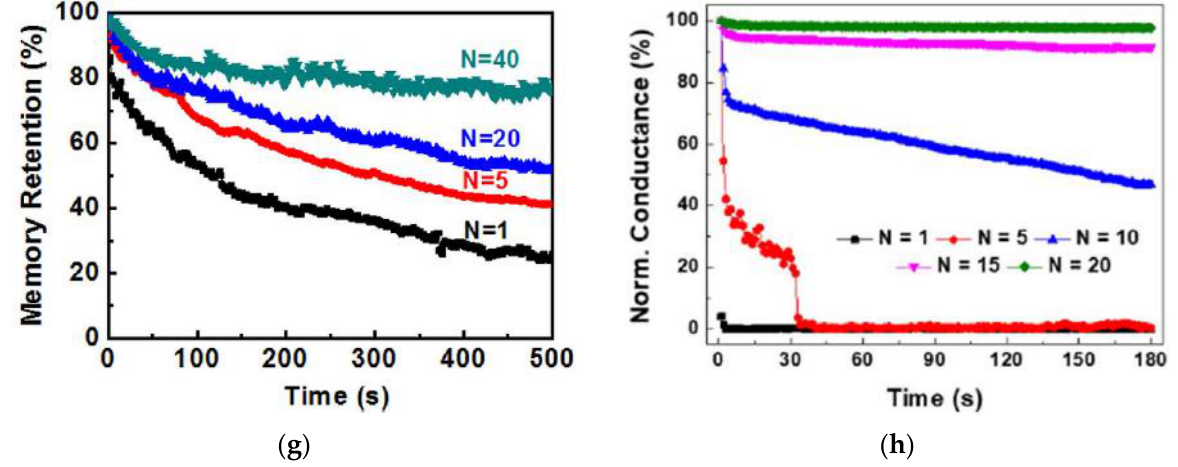
Figure 4. Current (memory) level and retention time affected by input pulse amplitude, which was demonstrated in ( a ) a chicken albumen transistor [43] and ( b ) a honey-memristor [17], pulse width, which was demonstrated by ( c ) a chicken albumen transistor [43], ( d ) a maltose-ascorbic acid electrolyte (MAE) gated transistor [56], and ( e ) a honey-memristor [17], and pulse number, which was demonstrated by ( f ) a honey-memristor [17], ( g ) a chicken albumen transistor [43], and ( h ) a zein-transistor [14].